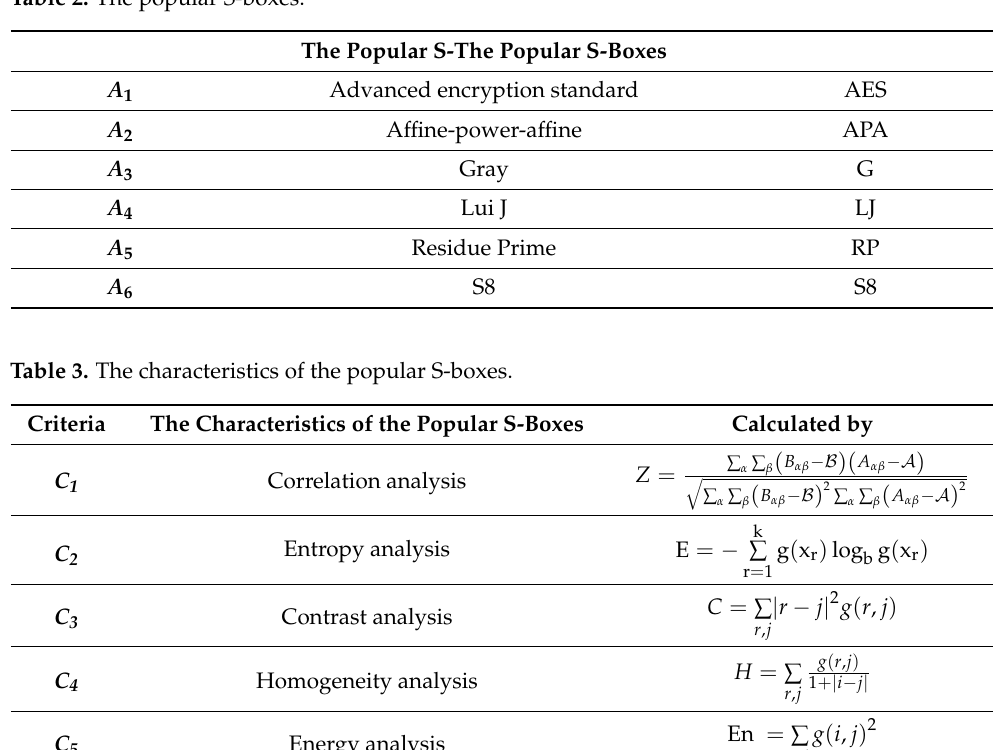
Table 2. The popular S-boxes.